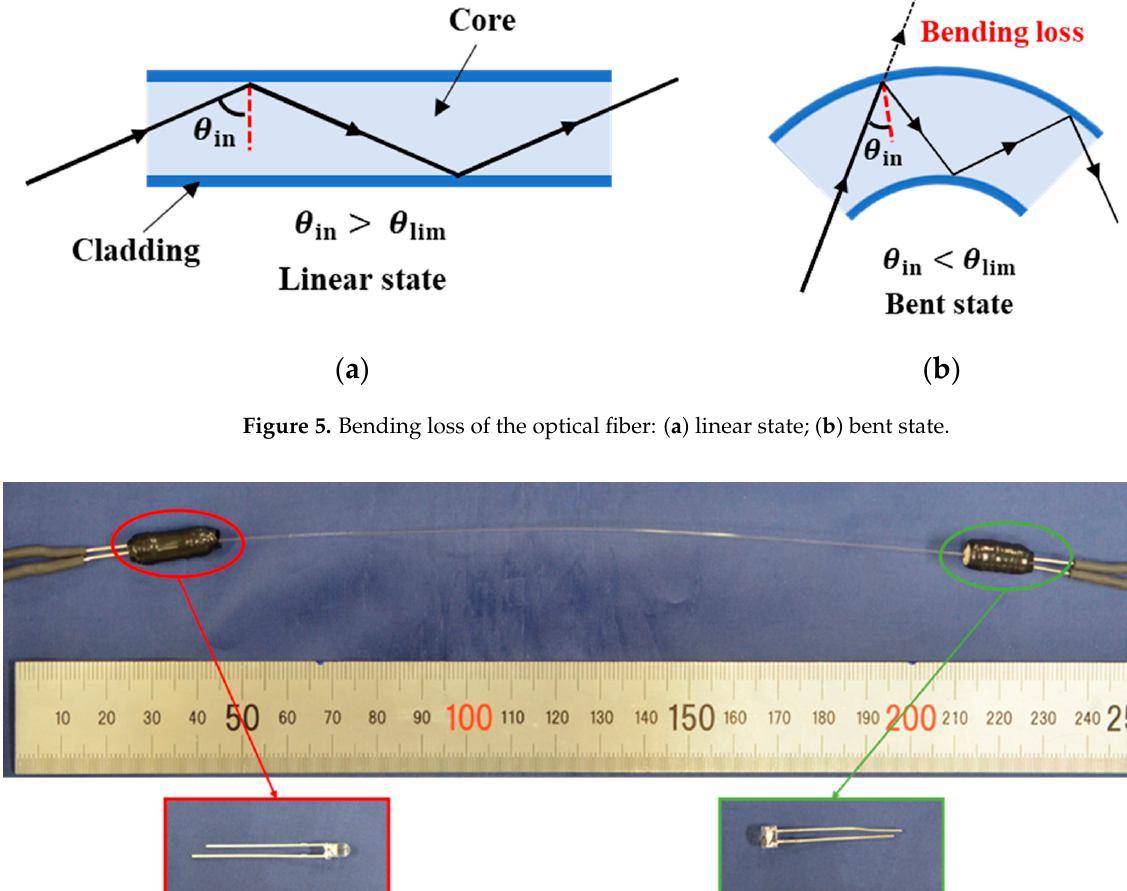
Figure 6. Appearance and structure of the step-index multimode optical fiber sensor.